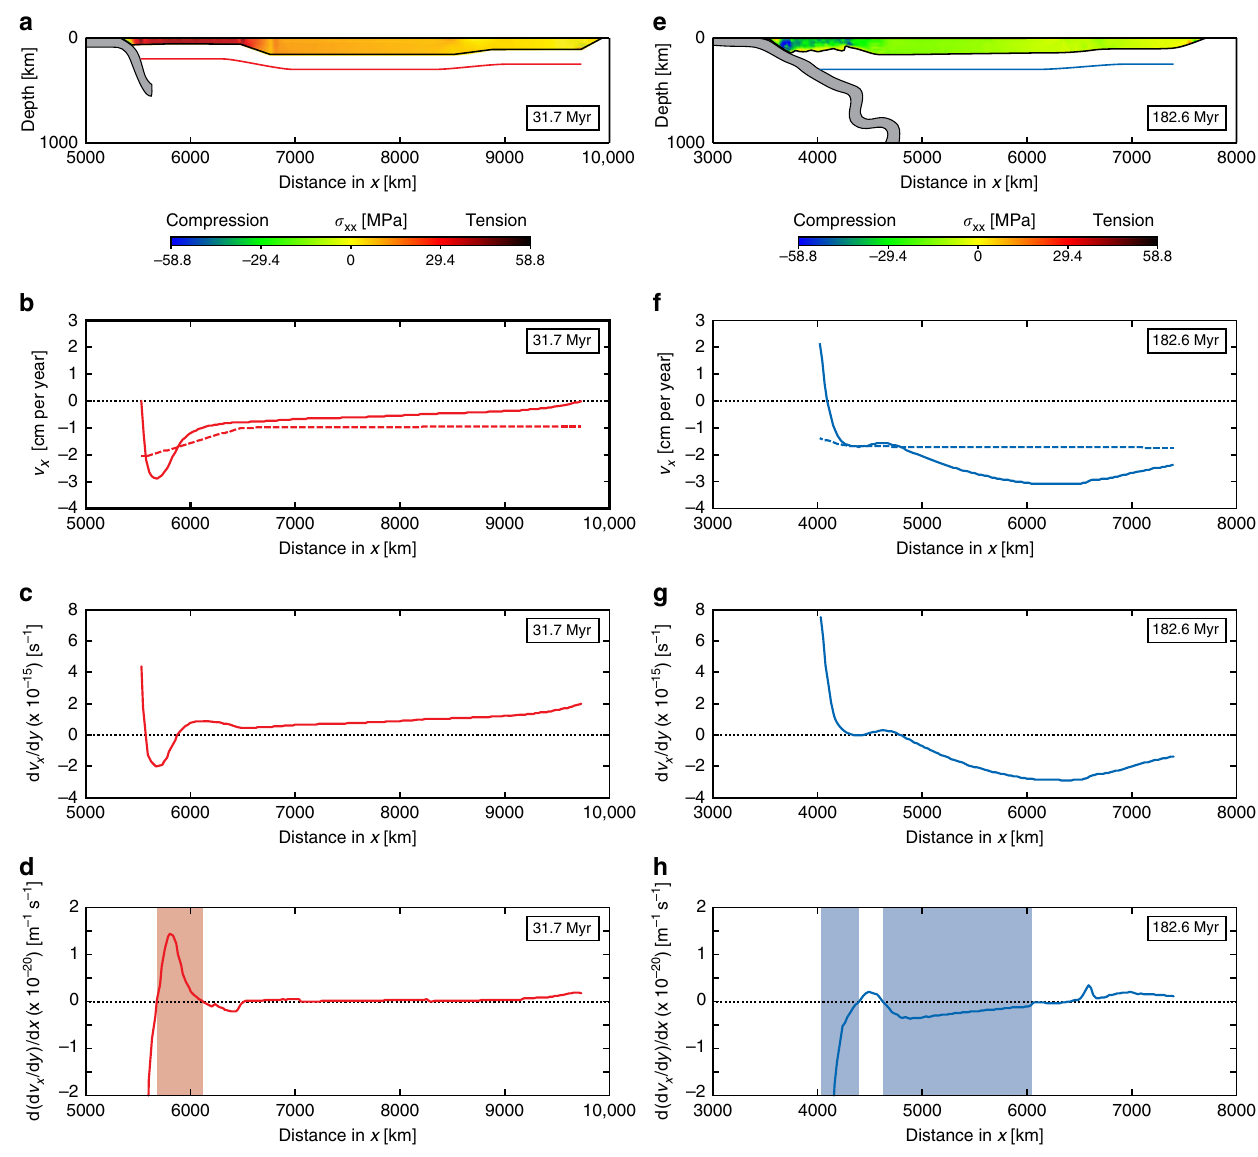
Fig. 5 Model results showing the horizontal velocity and shear rate and shear rate gradient in the centre of the subduction zone below the base of the overriding plate at 31.7 and 182.6 Myr. a , e Location of line at ~150 km below the base of the overriding plate, with colour scheme in overriding plate indicating trench-normal horizontal deviatoric normal stress ( σ XX ). b , f Horizontal trench-normal velocity in the mantle ( v x ) at ~150 km below the base of the overriding plate (continuous line) and in the overriding plate (dashed line). Note that the direction towards the right (in the positive x-direction) is taken as positive. c , g Average horizontal trench-normal shear rate (d v x /d y ) in a ~150 km thick mantle section below the base of the overriding plate. Note that a basal drag in the direction towards the right (in the positive x-direction) is positive. d , h Trench-normal horizontal gradient of the average horizontal trench-normal shear rate (d(d v x /d y )/d x ) in a ~150 km thick mantle section below the base of the overriding plate. Note that a positive gradient induces trench-normal overriding plate extension, while a negative gradient induces trench-normal overriding plate shortening. The pale red zone in d for 31.7 Myr indicates a zone with a strong positive gradient, while the pale blue zones in h for 182.6 Myr indicate zones with a strong negative